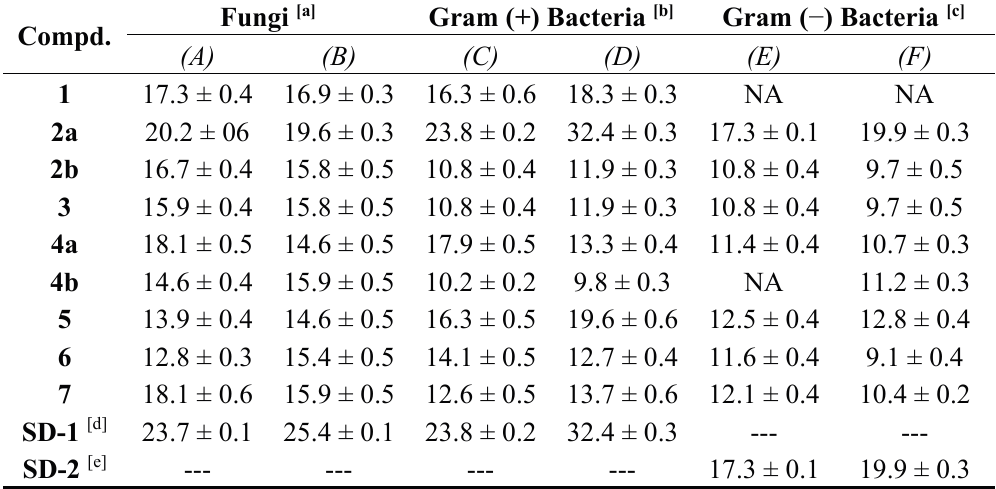
Table 1. Antibacterial and antifungal activity of synthesized